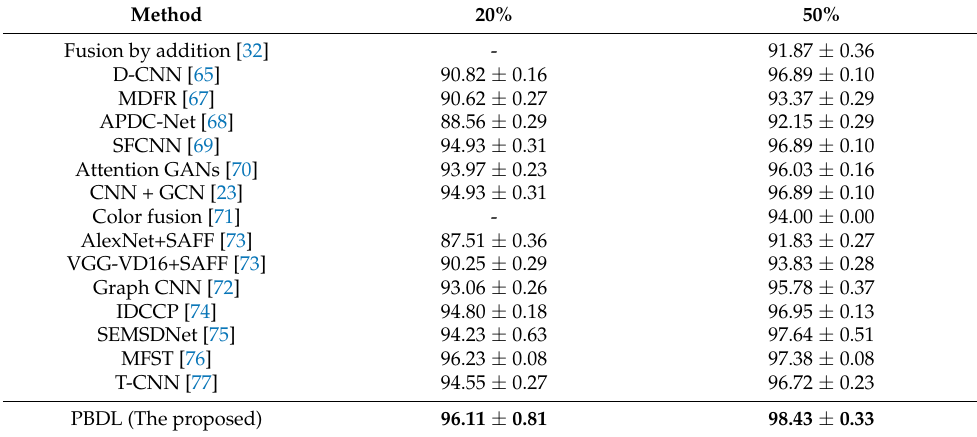
Table 6. Classification accuracy (%) for the AID dataset with two training ratios.The results are obtained directly from the corresponding papers. Method 20% 50% Fusion by addition [32]